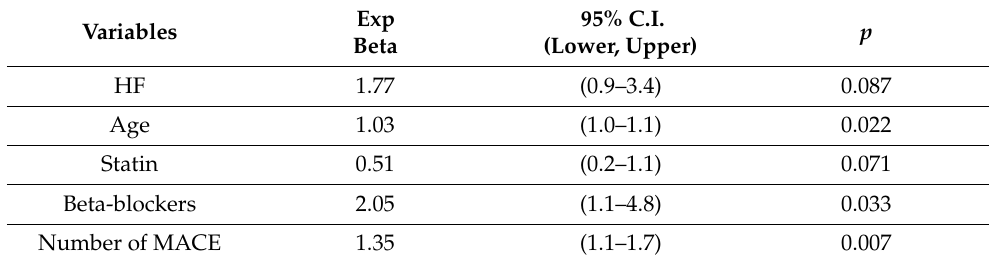
Table 7. Adjusted multivariate analysis for risk factors associated with high levels of sST2 (fourth quartile).